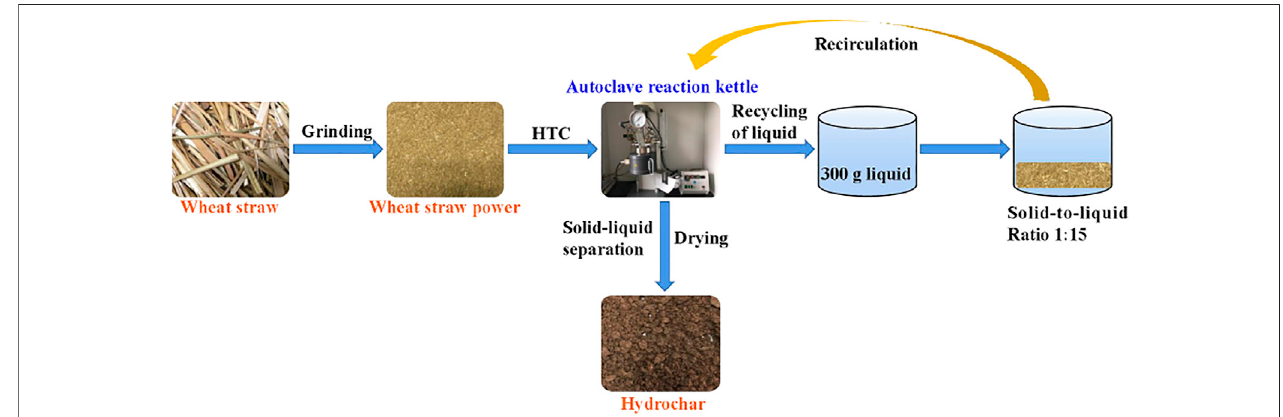
FIGURE 1 | Schematic diagram of process water recirculation during hydrothermal carbonization.